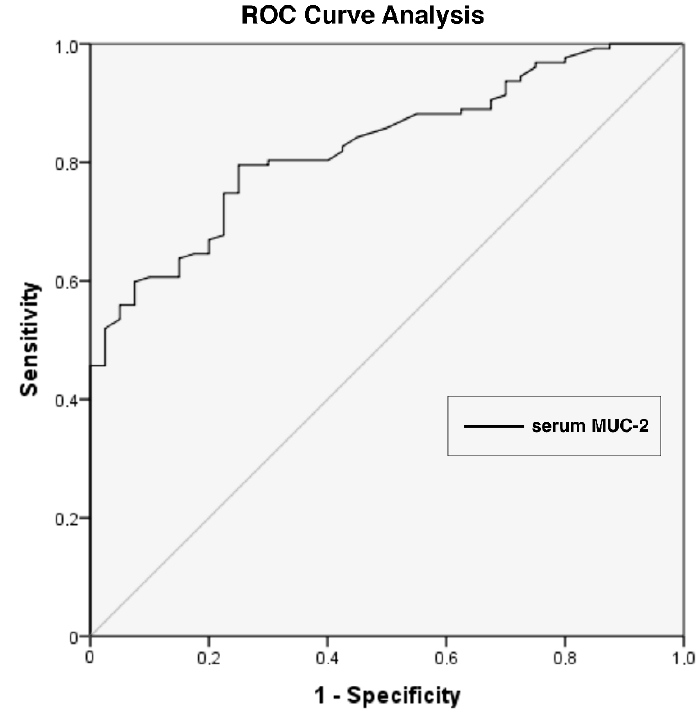
Figure 2. The receiver operating characteristic (ROC) analysis for serum MUC -2 levels ( p < 0.001). AUC (CI) = 0.82 (0.76–0.89), cut-off value = 97.5 ng/mL, PPV= 90.5%, NPV= 48.4%. AUC: area under the curve; CI: confidence interval; PPV: positive predictive value; NPV: negative predictive value.